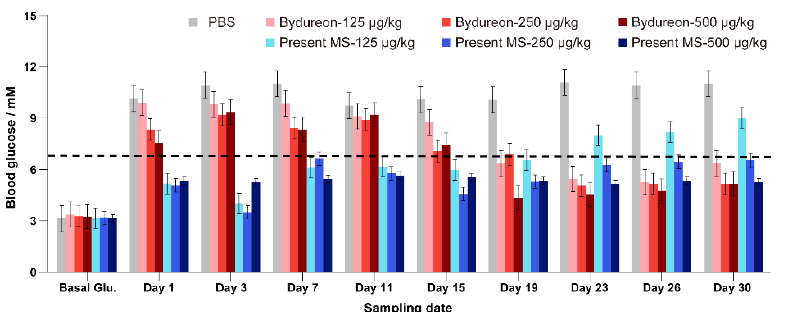
Figure 8. Plasma concentrations of exenatide released from the microspheres of the present study and commercial product Bydureon TM in rhesus monkeys (means ± SD, n = 5). 1: PBS, 2: Bydureon at 125 µg/kg, 3: Bydureon at 250 µg/kg, 4: Bydureon at 500 µg/kg, 5: Present MS at 125 µg/kg, 6: Present MS at 250 µg/kg, 7: Present MS at 500 µg/kg (1 vs. 2–7, p < 0.05; 2 vs. 5, p < 0.05; 3 vs. 6, p < 0.05; 4 vs. 7, p <